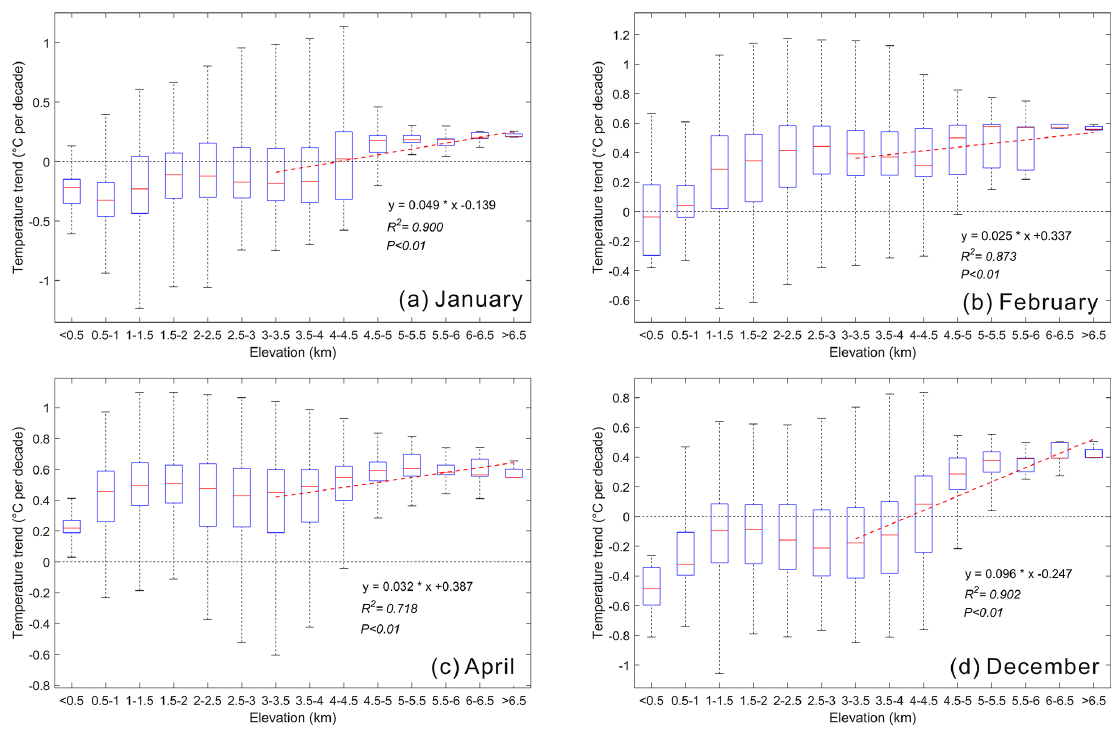
Figure 2. Box plots of monthly minimum temperature trends at different altitudes from 1979 to 2016. (a) January, (b) February, (c) April and (d) December. Thick horizontal lines in boxes show the median values. Boxes indicate the inner-quantile range (25% to 75%) and the whiskers show the full range of the values. The red dashed lines represent the significance of EDW by fitting the temperature trends and altitude groups above